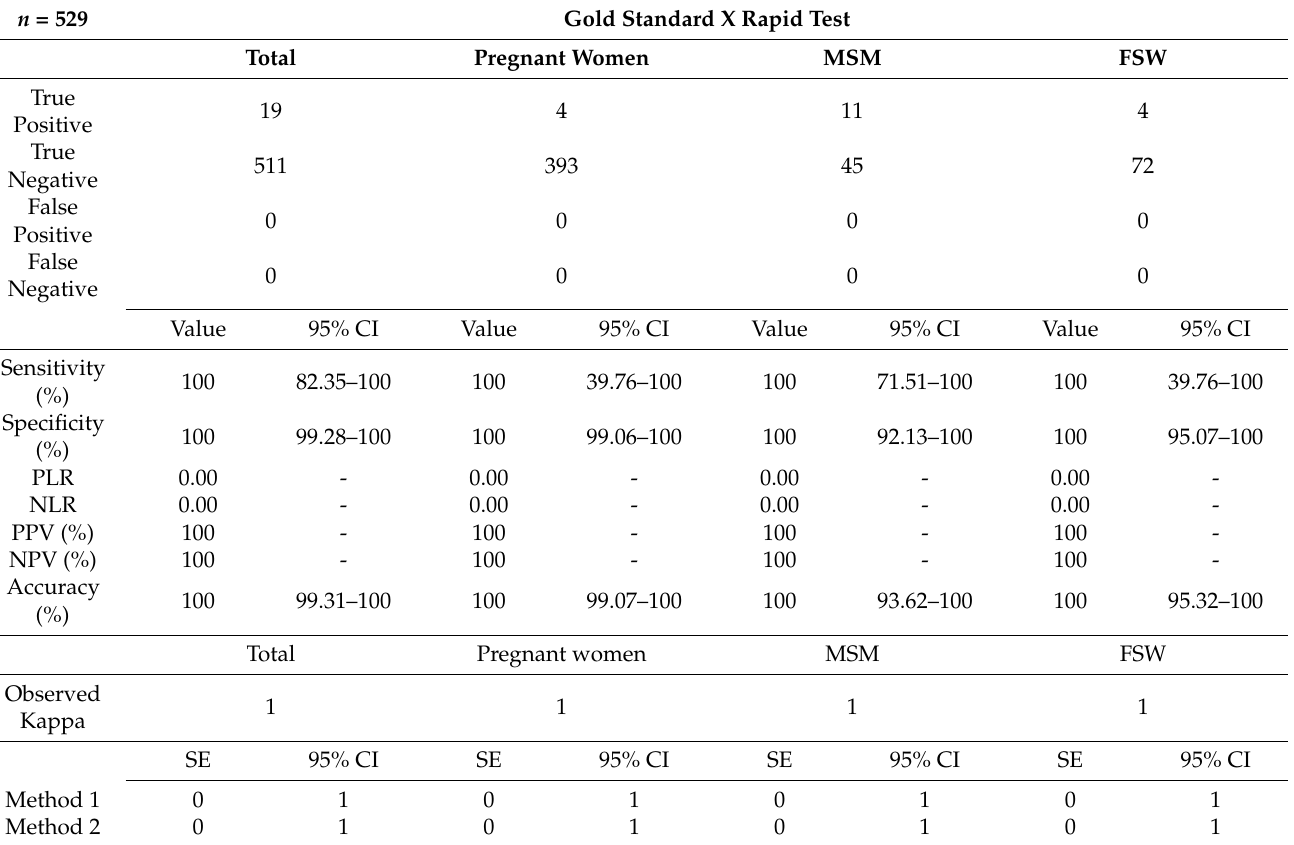
Table 2. Concordance performance of the rapid Duo test with the reference test for